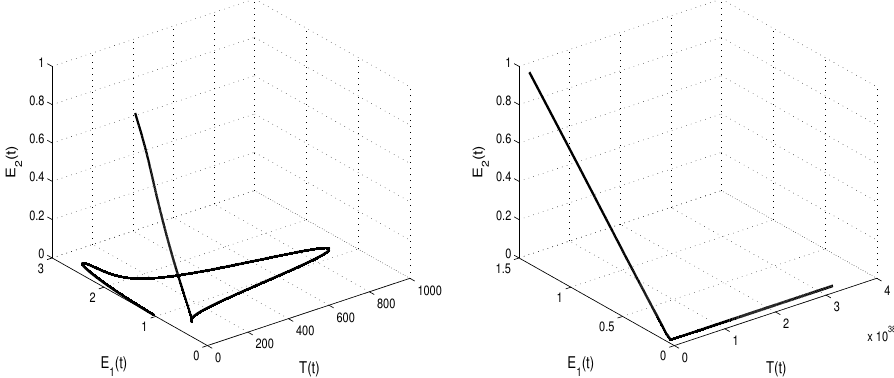
Figure 3. Shows the stability ( left ) of the solution of the deterministic system (1) when d 1 = 0.92 = d 2 < 1 and instability ( right ) of the solution when d 1 = d 2 = 1.02 >